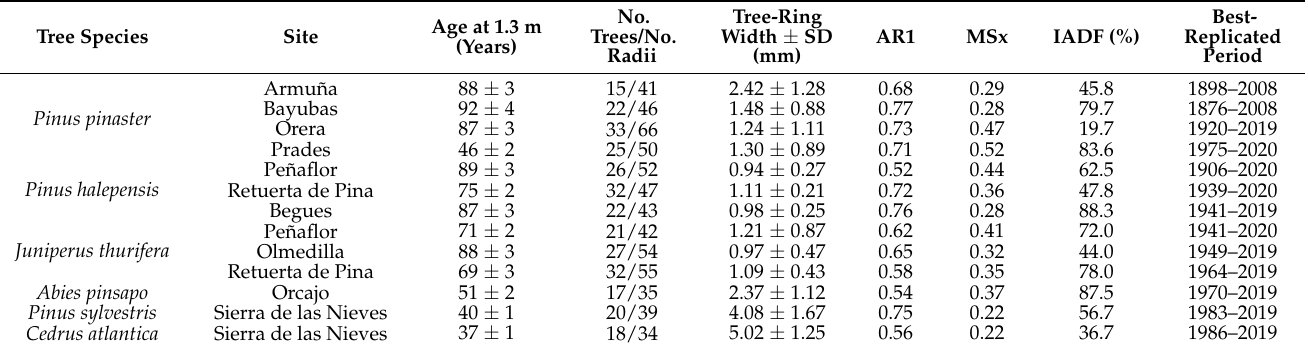
Table 2. Age and tree growth data and statistics calculated for the sampled sites. Variables’ abbre- viations: AR1, first-order autocorrelation; MSx, mean sensitivity; IADF, percentage of years with latewood IADFs in the mean site